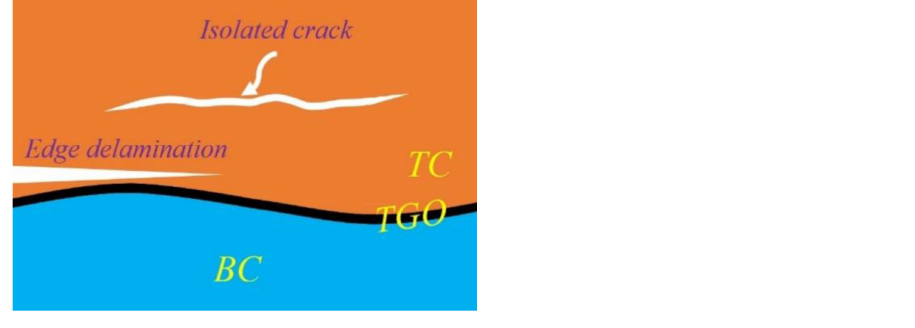
Figure 6. Schematic illustration of three potential delamination modes of TBC in the presence of a thermal gradient